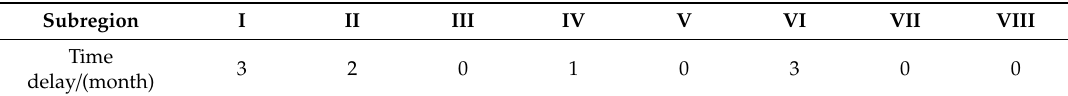
Figure 16. Time delay e ff ects of extreme climate factors on NDVI over the Loess Plateau region. Table 6. Time delay e ff ects of DTR with di ff erent time lengths on vegetation growth in various subregions of the Loess Plateau